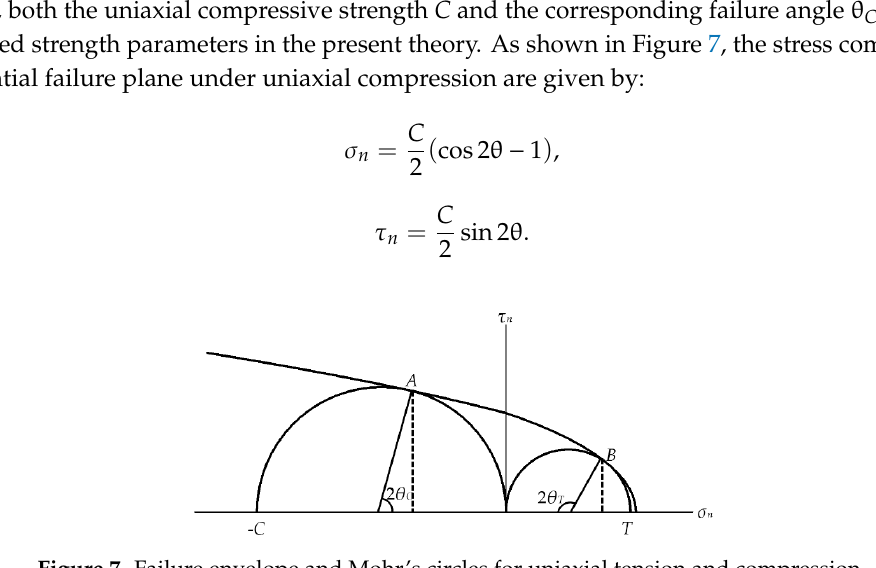
Figure 7. Failure envelope and Mohr’s circles for uniaxial tension and compression.